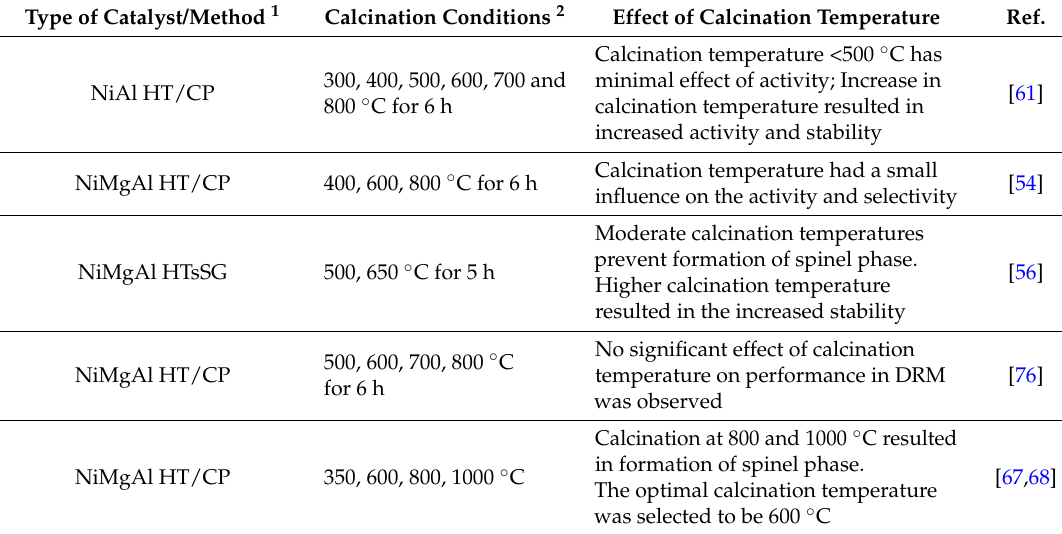
Table 3. The effect of calcination temperature on hydrotalcite (HT)-derived materials in dry reforming of methane